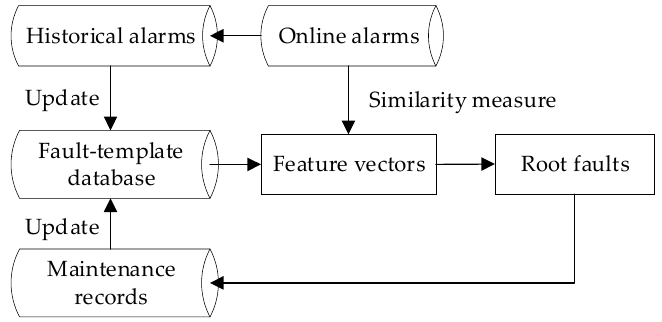
Figure 4. The self-optimizing process of the proposed method.